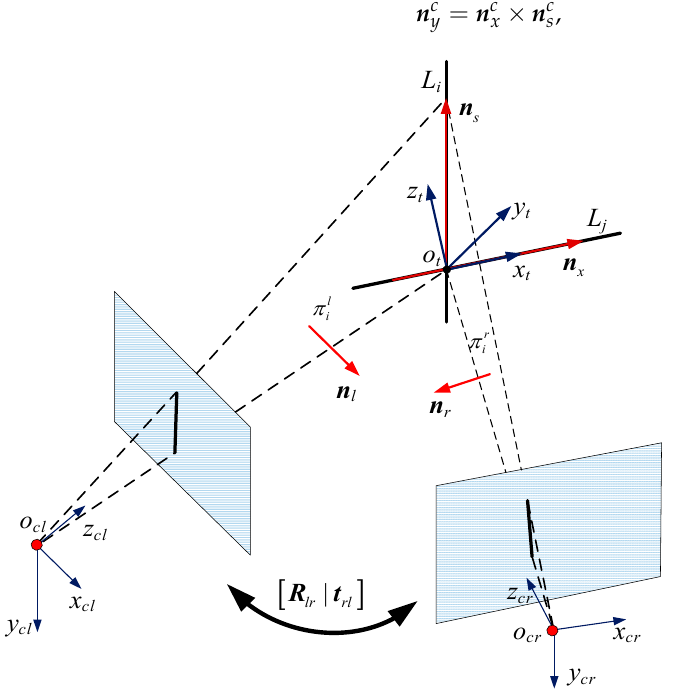
Figure 2. Schematic diagram of the spatial straight ‐ line perspective projection imaging.